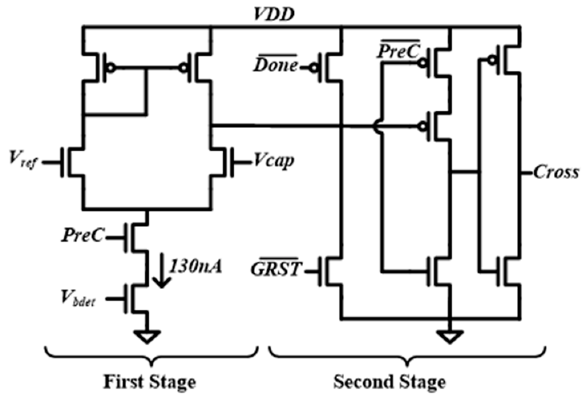
Figure 4. Schematic of the proposed charge detector.